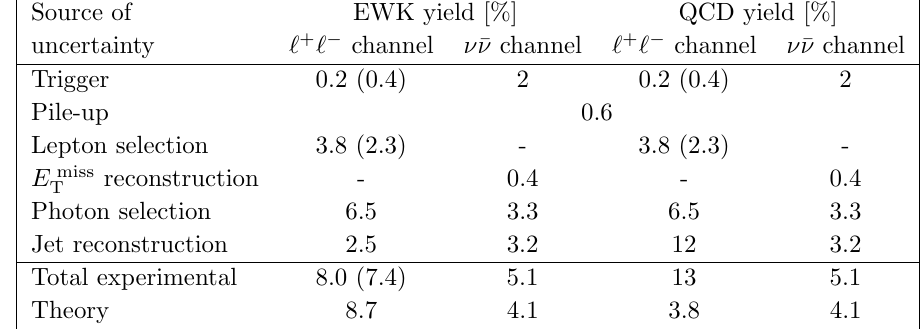
Table 4 . Summary of the main relative uncertainties in the MC-based EWK and QCD yields for the electron (muon when di(cid:11)erent) and neutrino channels in the aQGC region. The uncertainties in the Z +jets, W ( ‘(cid:23) ) (cid:13) +jets, (cid:13) +jets, and W ( e(cid:23) )+jets yields, estimated with data, are detailed in the text.